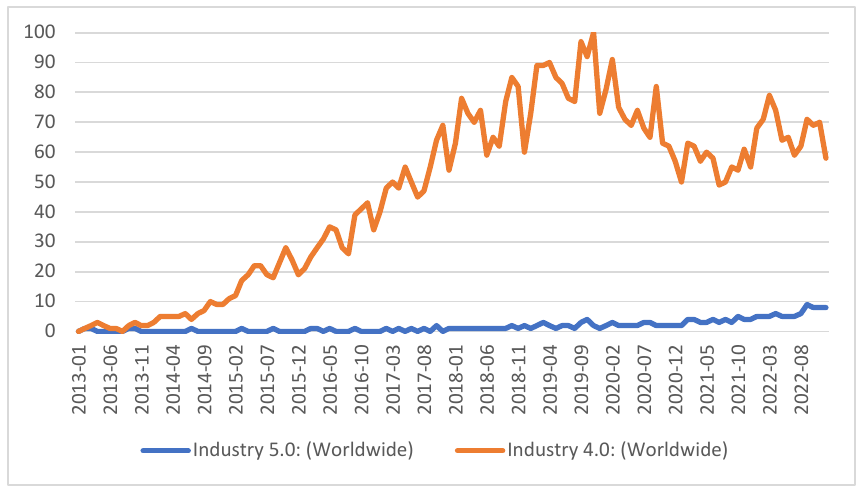
Figure 3. Google Trends for the terms “Industry 5.0” and “Industry 4.0” (Source: Google Trends).